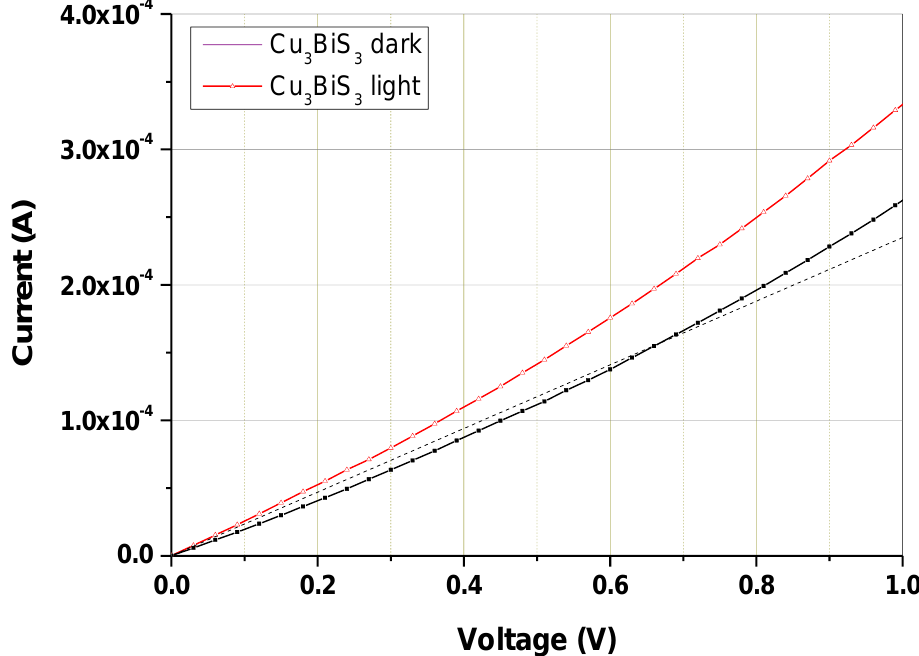
Figure 8. Measured current – voltage characteristics in the dark and under illumination.